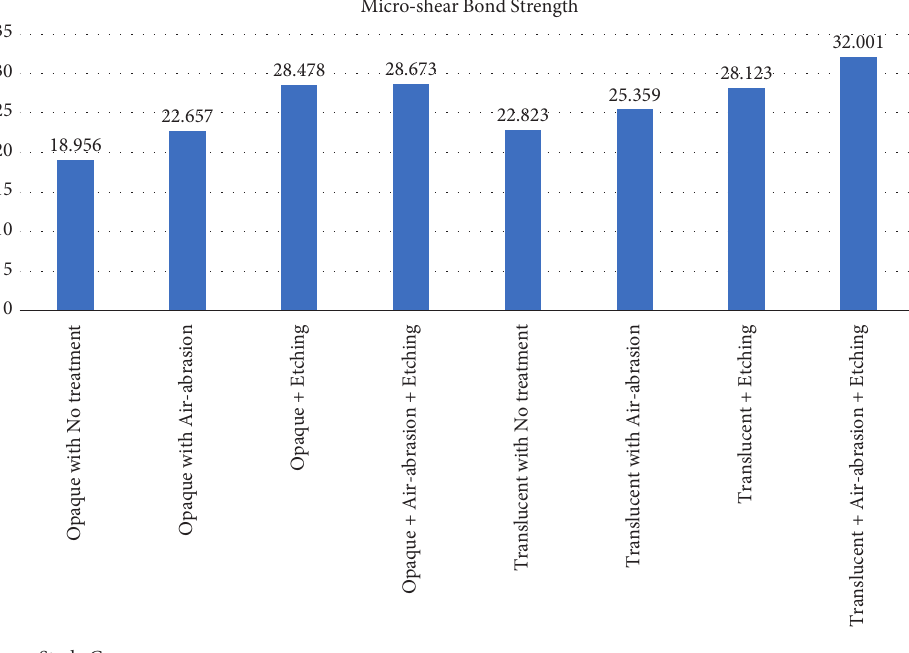
Figure 3: Mean micro-shear bond strength ( µ SBS) values in MPa for all the groups.